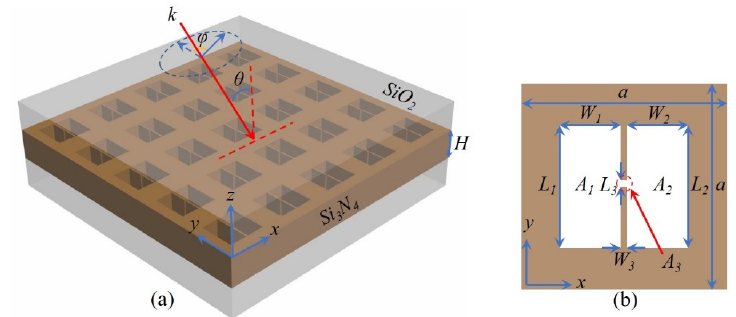
Figure 1. ( a ) Three − dimensional schematic diagram of dielectric metasurface with H − shaped nano- Figure 1. ( a ) three-dimensional schematic diagram of dielectric metasurface with H-shaped nanoholes holes surrounded by SiO 2 ; ( b ) x − y cross − section of the nanohole array in a la tt ice. surrounded by SiO 2 ; ( b ) x-y cross-section of the nanohole array in a lattice. BICs are identi fi ed as localized states coexisting with extend modes within the light